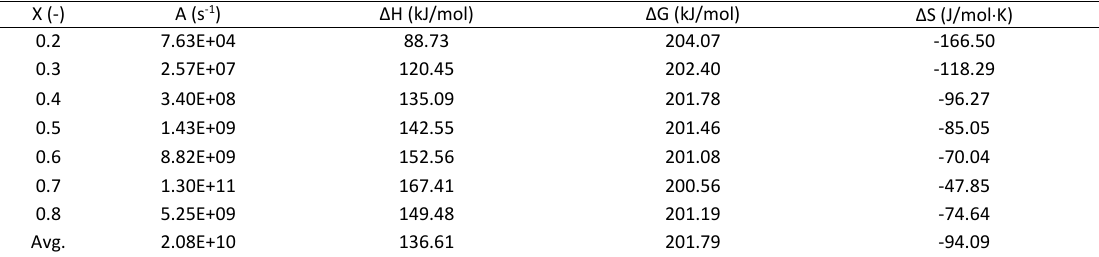
Table 9: Thermodynamic analysis of pellets at 15 °C/min